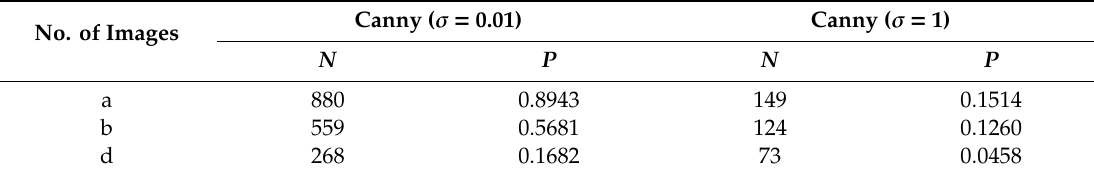
Table 1. Evaluations of fusion effects in Figure 3.